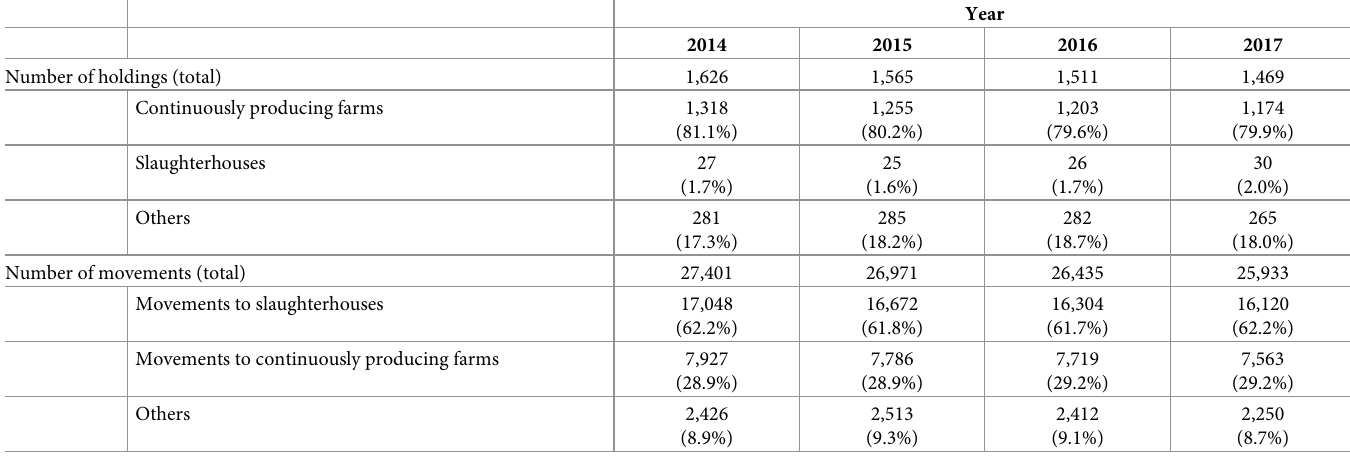
Table 2. Number of holdings and number of movements in TRP over the observation period (2014–2017). ‘Others’ includes different holding types such as trading companies, markets, and veterinary